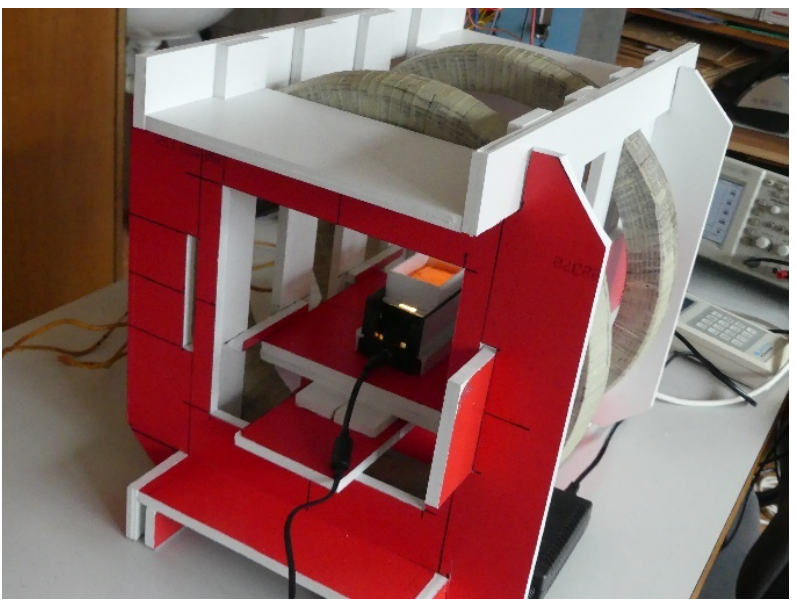
Figure 1. Experimental measuring